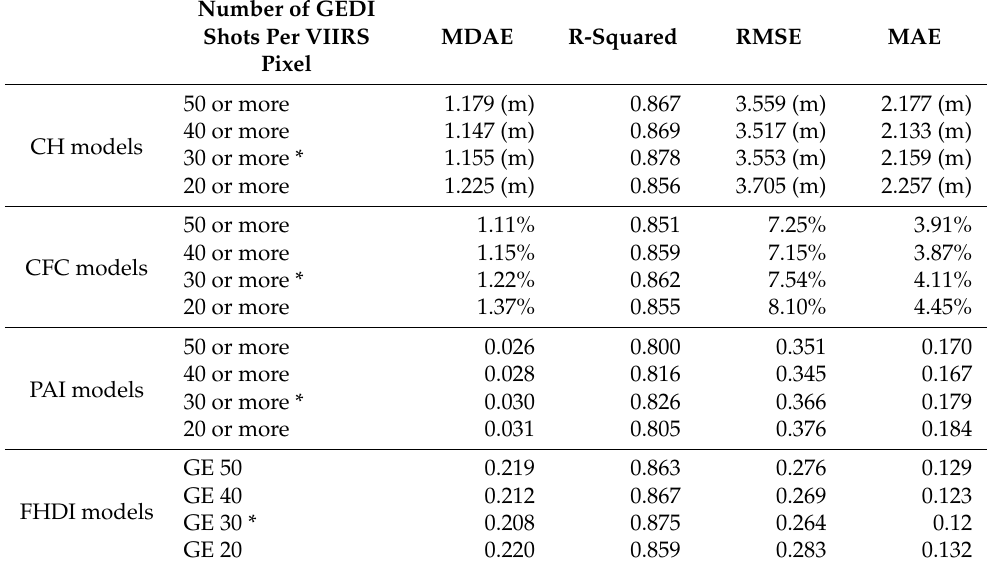
Table 9. Performance metrics of the Random Forest Regression models against the set-aside 2019 GEDI test